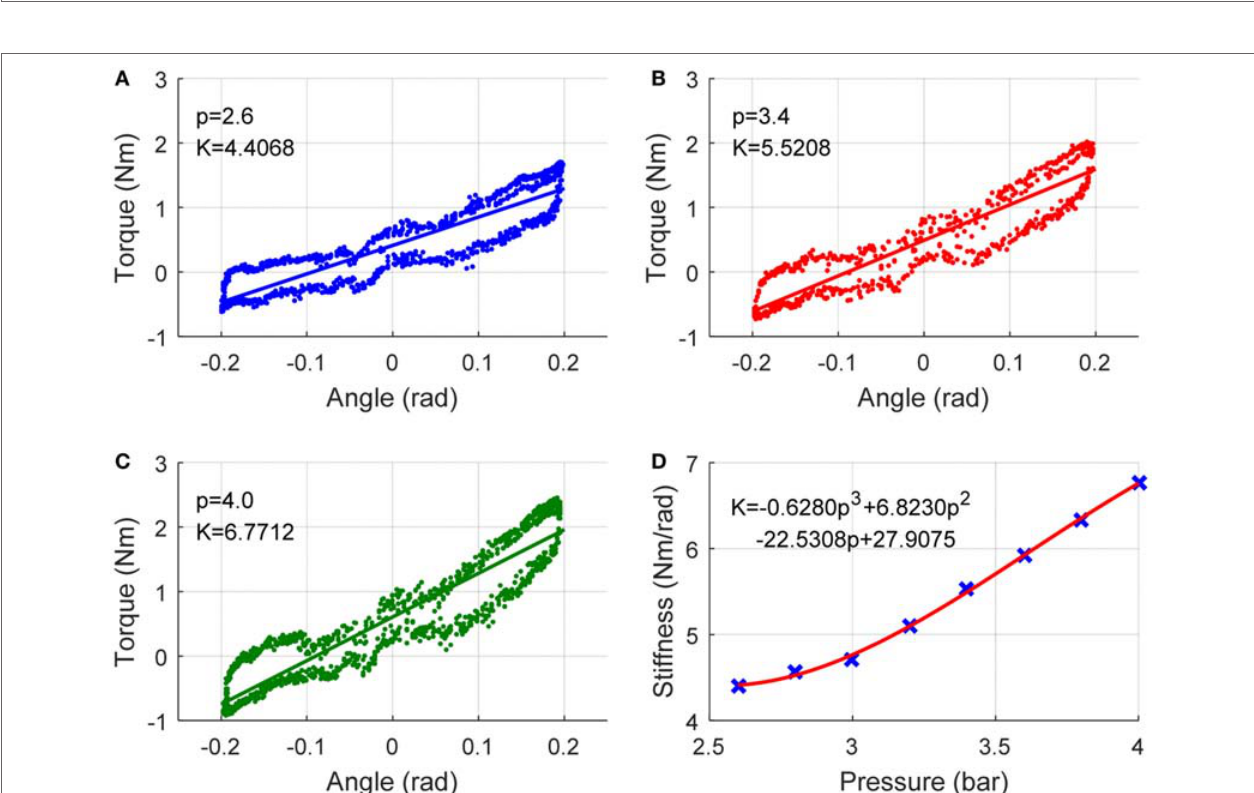
FIGURE 5 | Robot inherent compliance adapted by nominal pressure about Y (IE) axis. (A–C) the robot toque vs angle (to get stiffness K y rob ) under three different pressures and (D) robot stiffness as a function of pressure, where the crosses denote seven pairs of robot stiffness vs pressure.